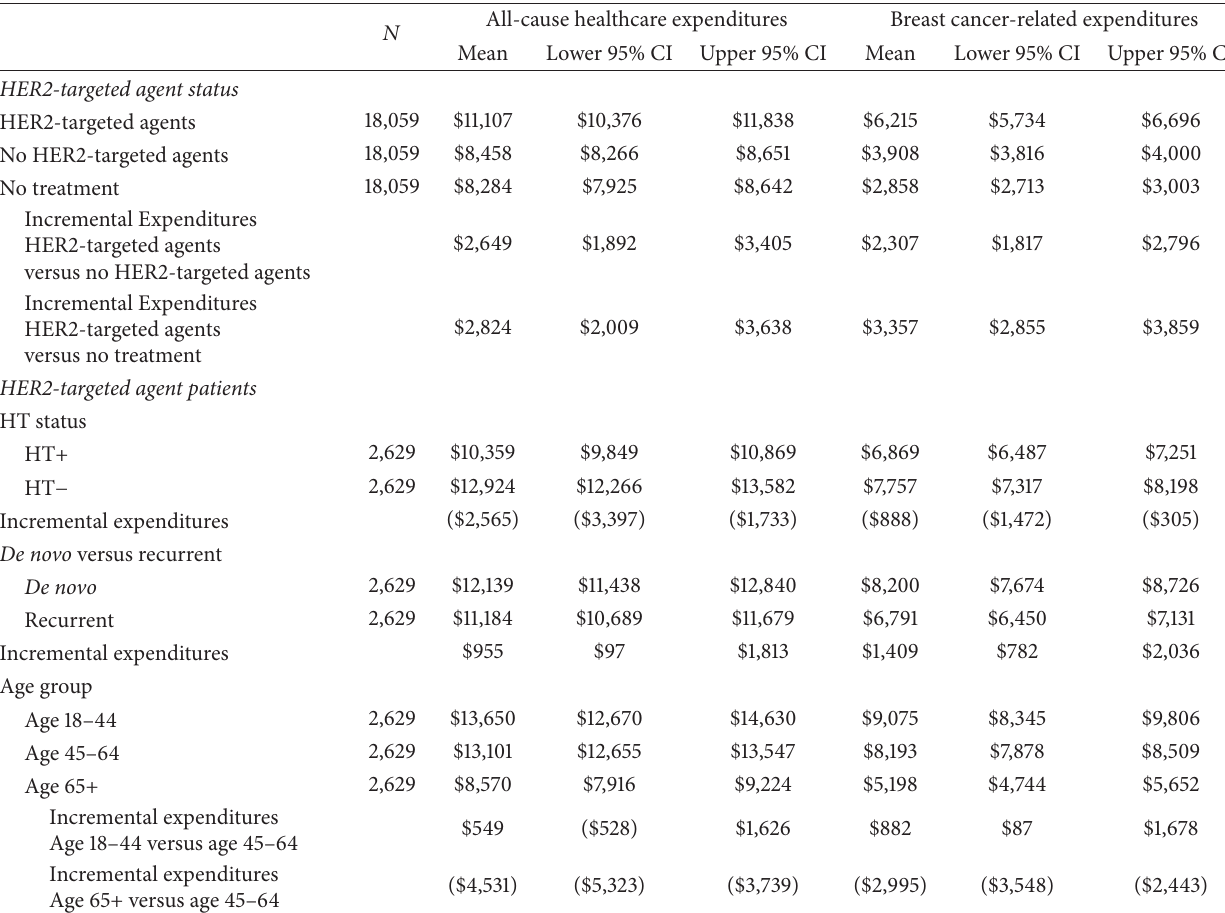
Table 7: Adjusted